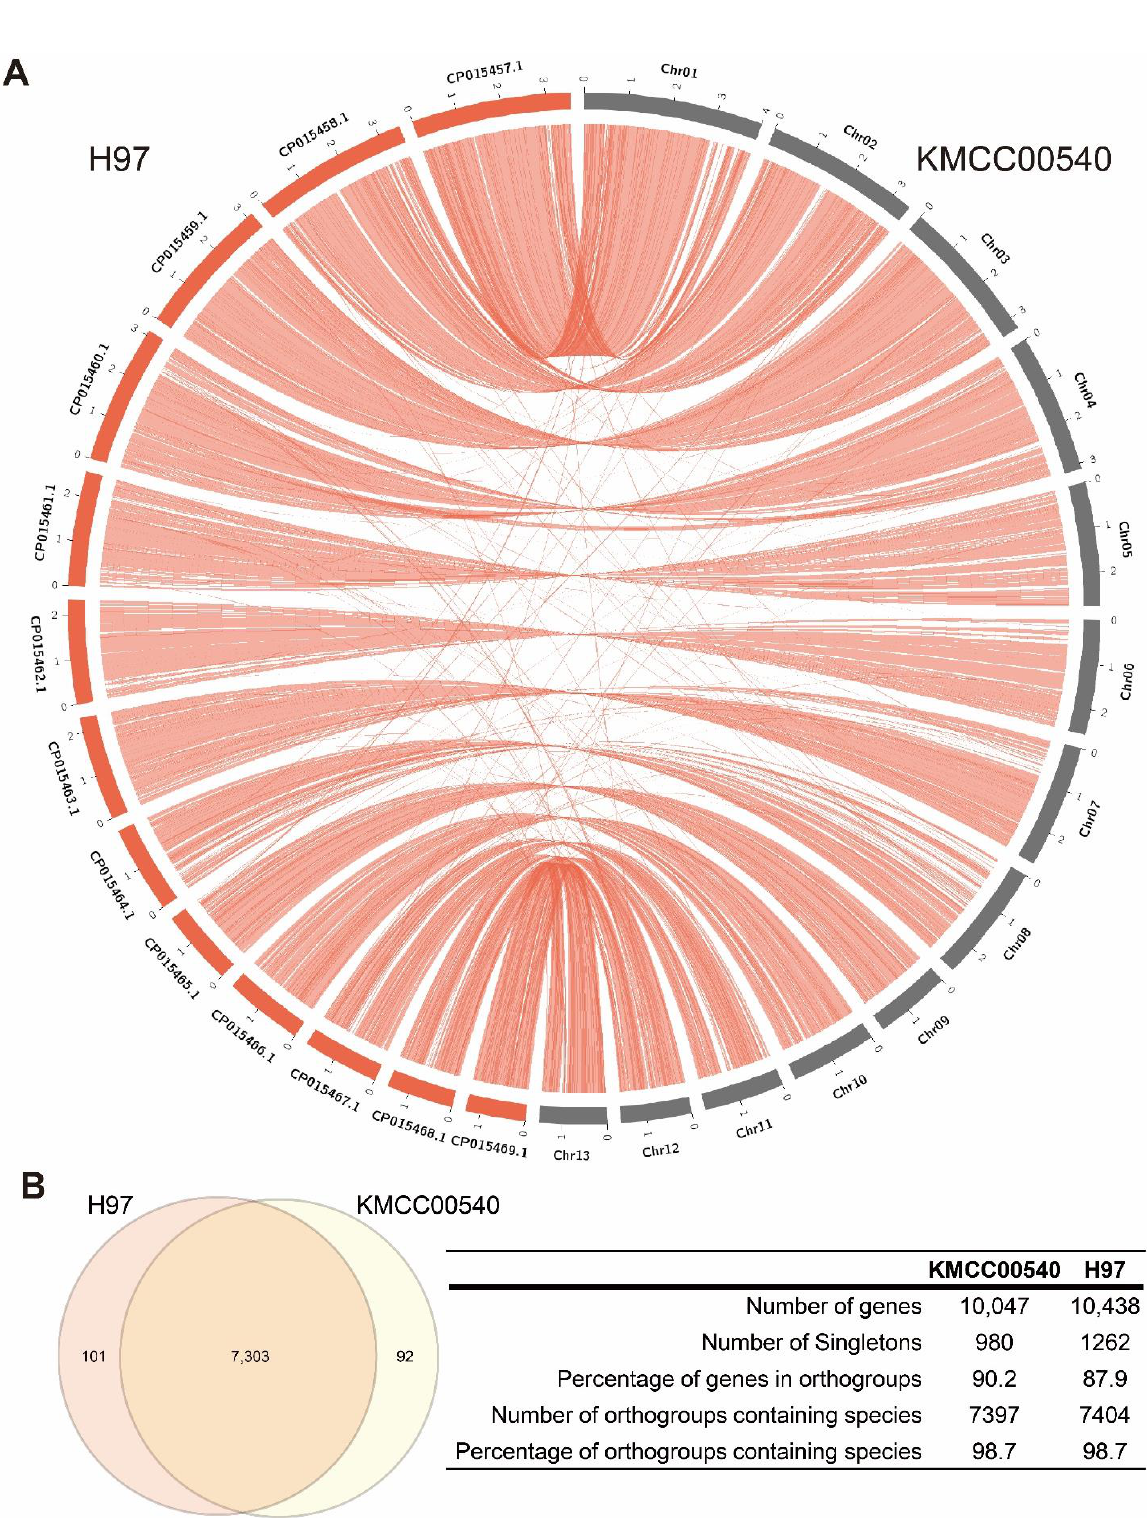
Figure 1. Comparative analysis of the circular diagrams and gene clustering between two A. bisporus genomes. ( A ) Circos plots representing the three A. bisporus genomes, with structural alterations noted. Inter-chromosomal and intra-chromosomal rearrangements for the two strains are shown in red. ( B ) Venn diagram of the distribution of shared gene families (orthologous clusters) in A. bisporus KMCC00540 and H97 strains. The numbers of each component are shown in the